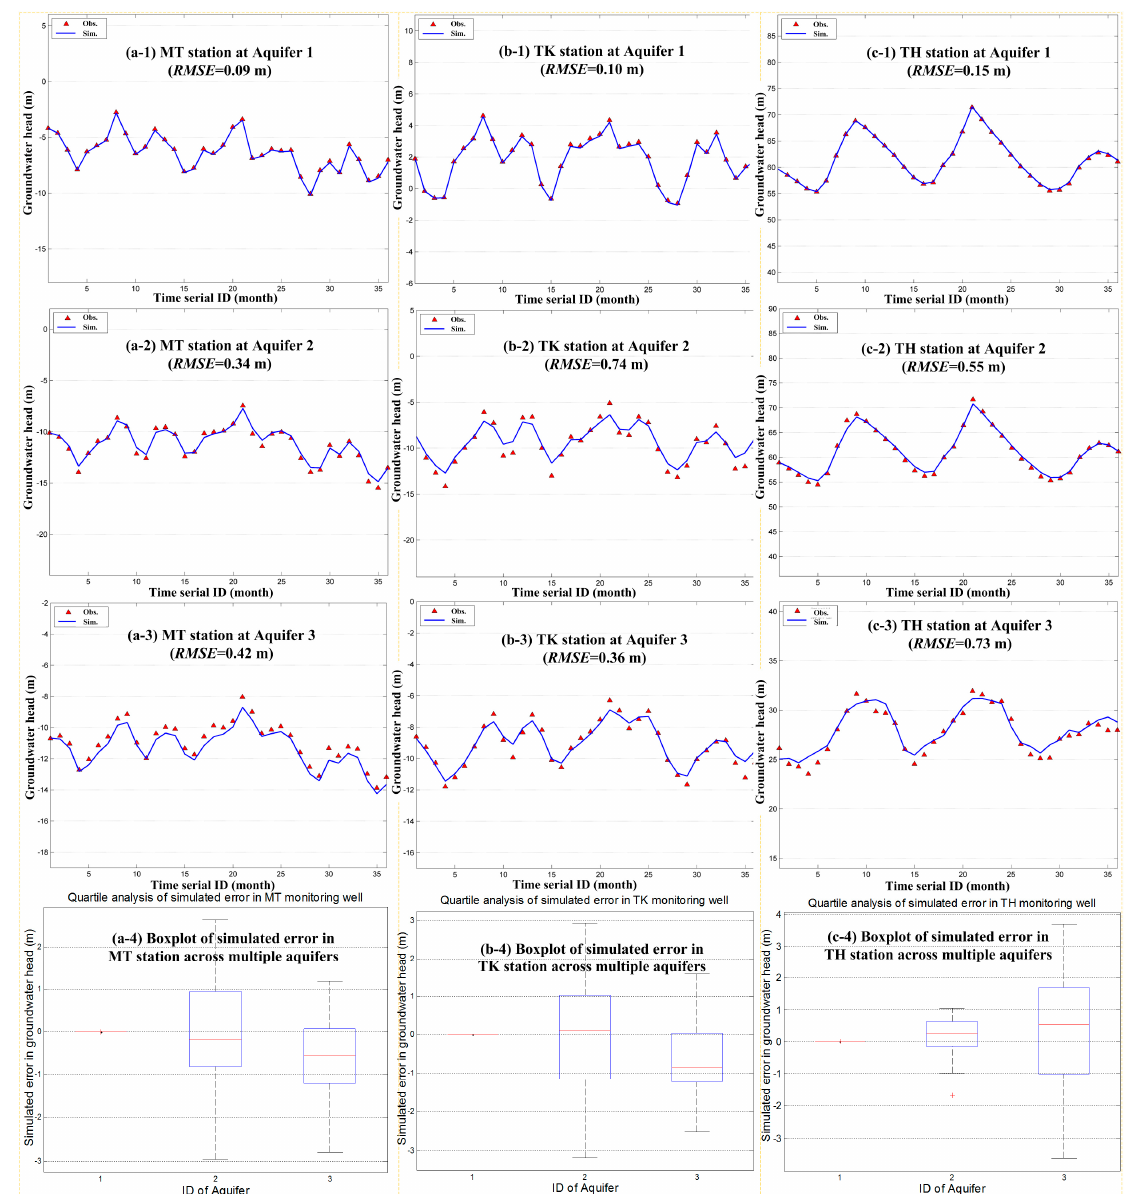
Figure 14. Comparison among simulated and observed groundwater head hydrographs: ( a ) MT station; ( b ) TK station; ( c ) TH station; (-1) Aquifer 1; (-2) Aquifer 2; (-3) Aquifer 3; and (-4) quartile analysis of simulated error.